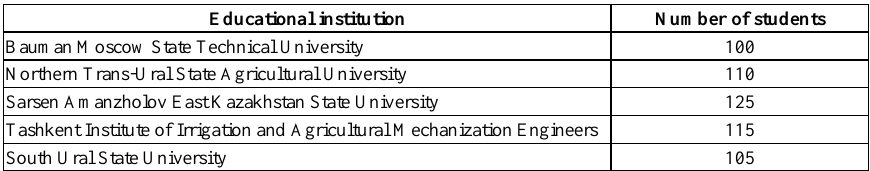
Table 1. Research Sample